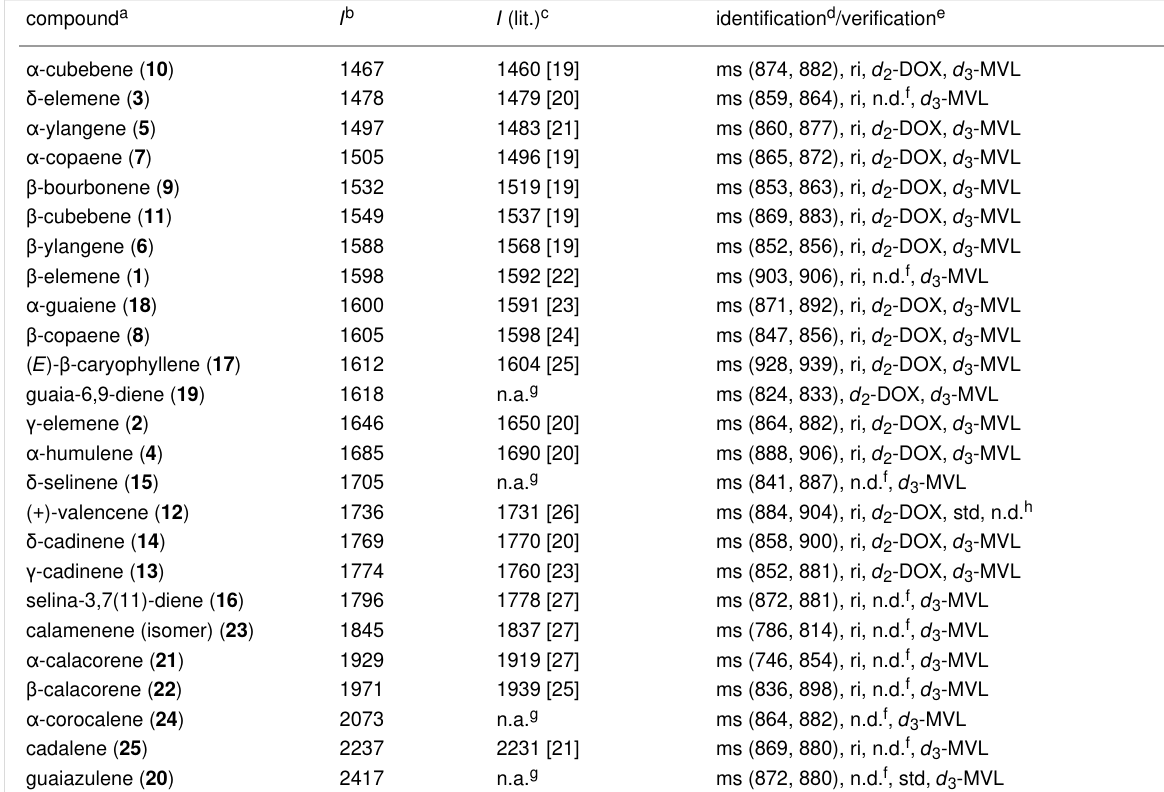
Table 1: Sesquiterpene hydrocarbons identified in headspace of Lemberger ( Vitis vinifera subsp. vinifera , clone 1Gm, exocarp). compound a I (lit.)